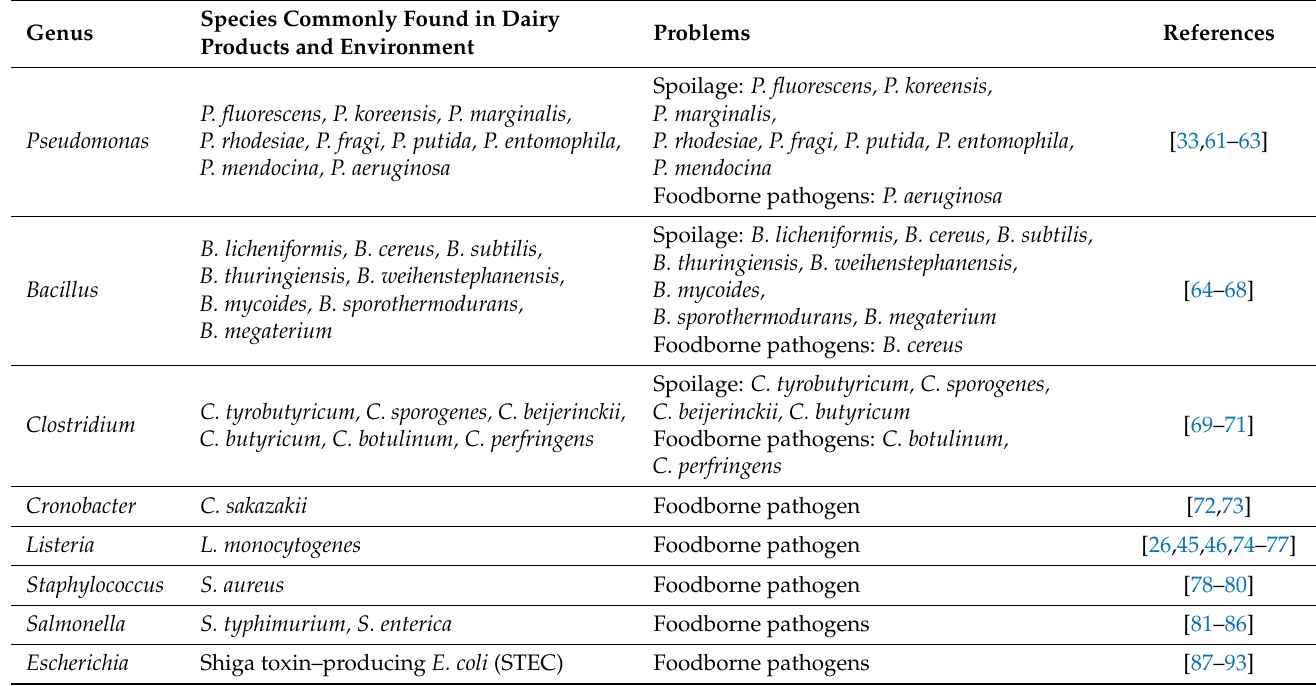
Table 1. Bacteria able to form biofilms in the dairy